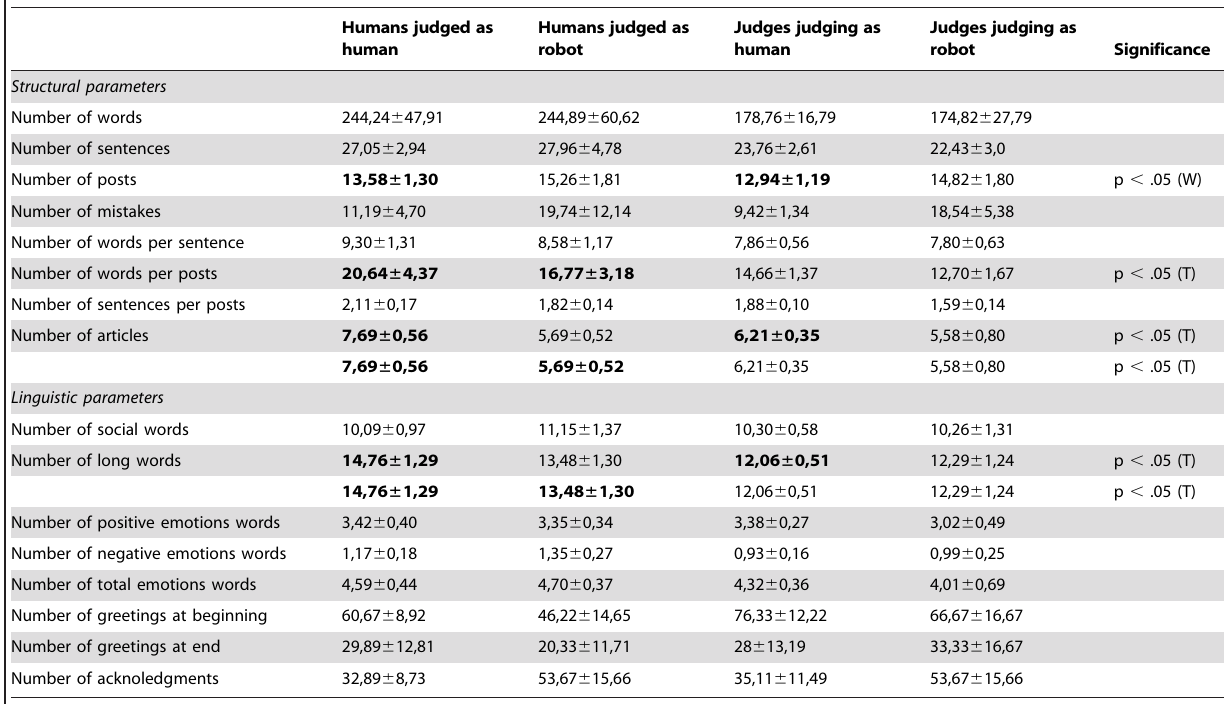
Table 2. Descriptive parameters.